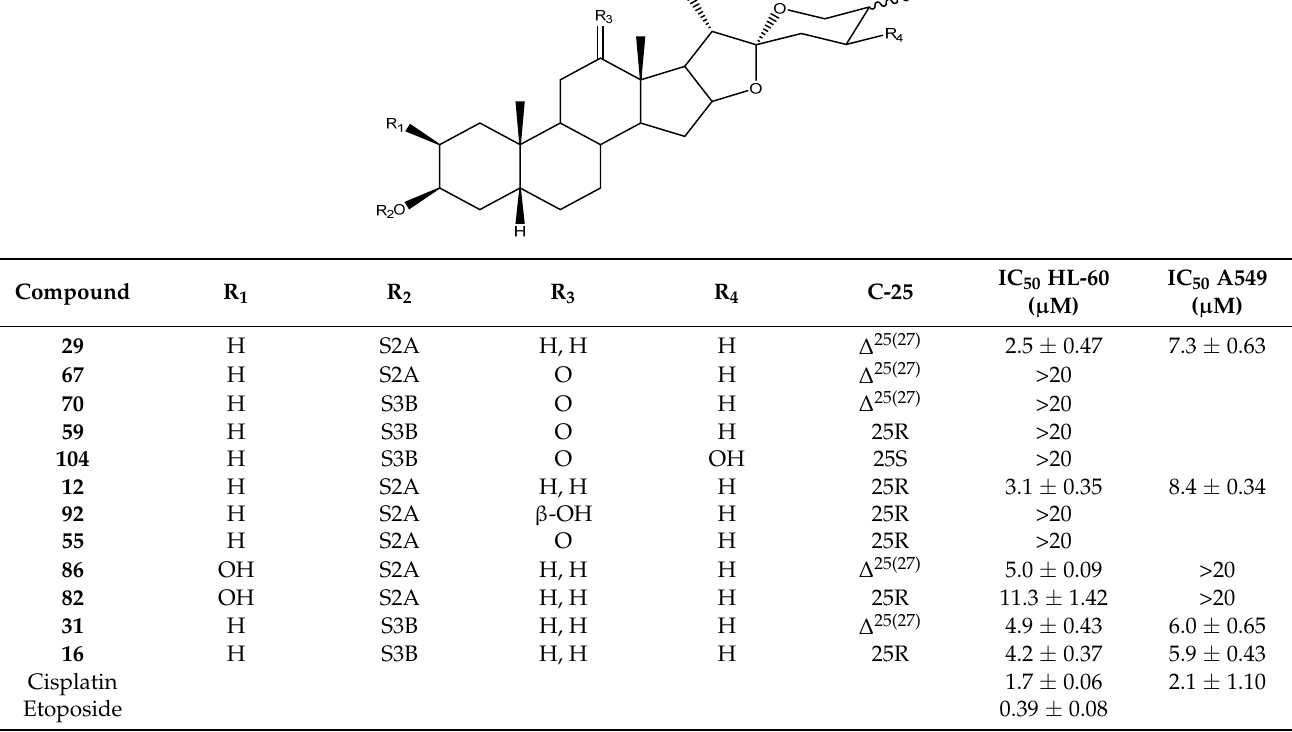
Table 3. Bioactivity of furostanic saponins by Y. glauca and by Cisplatin and Etoposide as control substances